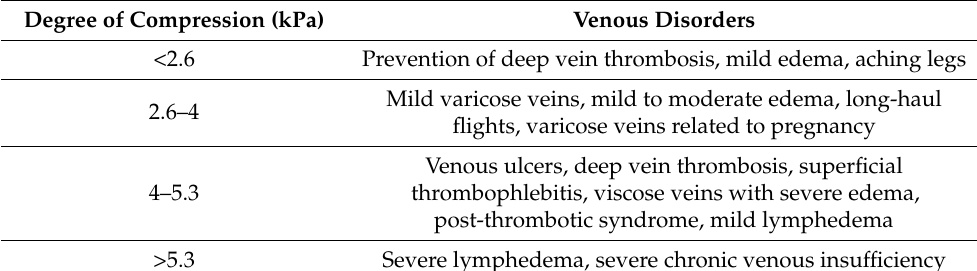
Table 1. Recommended degree of compresion